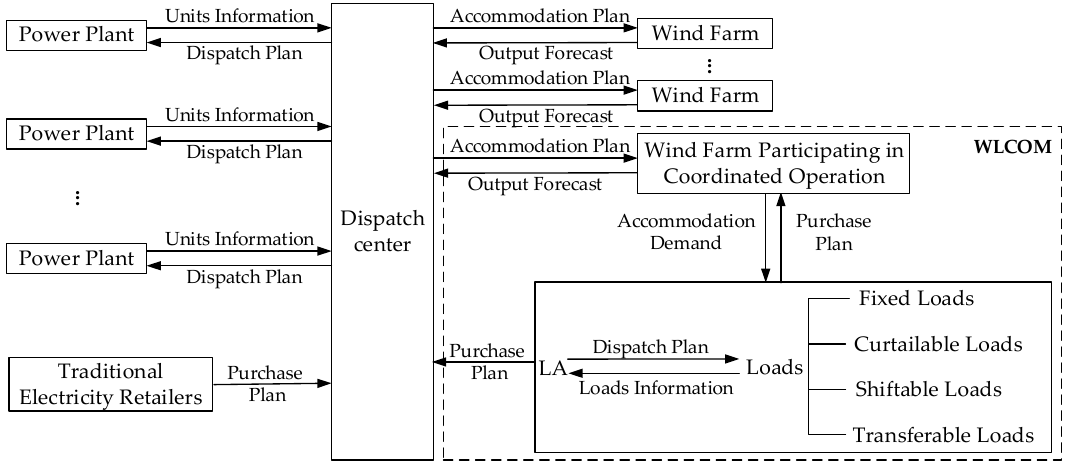
Figure 1. Schematic diagram of wind farm–load aggregator (LA) coordinated operation mode (WLCOM).